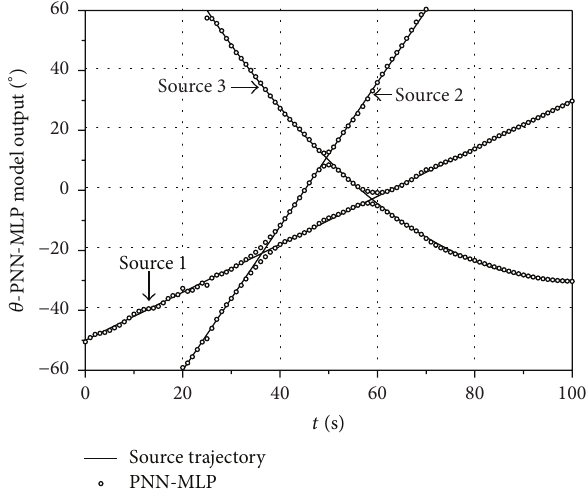
Figure 11: The time domain results of DoA estimation of variable number of mobile sources that are present in appropriate moments intimeinthesector [−60 ∘ 60 ∘ ] inazimuthplane,obtainedbyPNN- MLP model for the case 𝑆 = 3